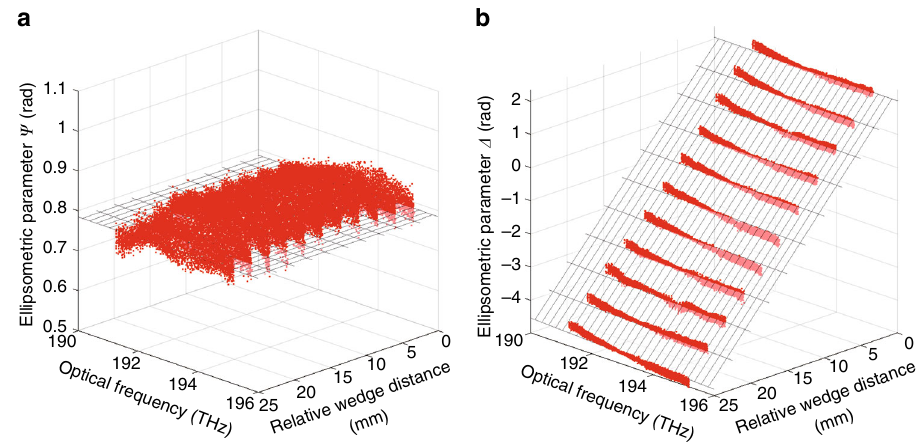
Fig. 2 Ellipsometric evaluation of a Soleil-Babinet compensator using the DCSE system. The ellipsometric parameters, a Ψ and b Δ , obtained using the DCSE system ( red dots ) and through theoretical estimation ( mesh